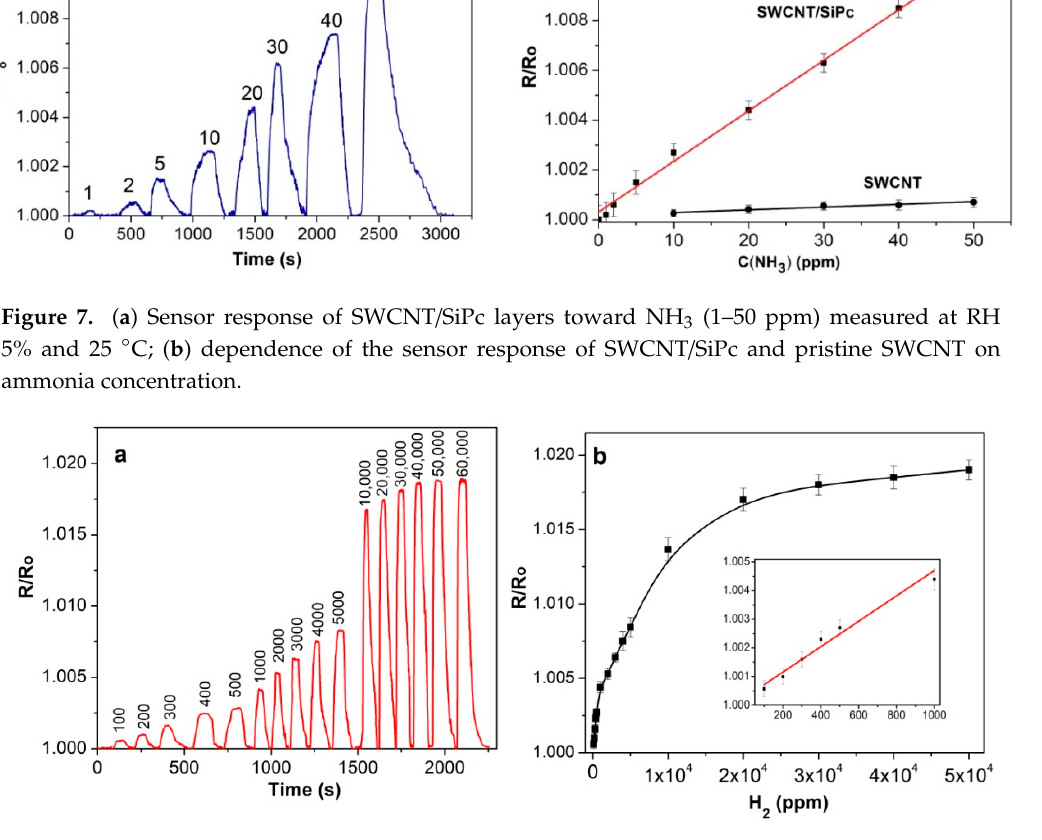
Figure 8. ( a ) Sensor response of SWCNT/SiPc layers toward H 2 (100–60,000 ppm) measured at RH 5% and 25 °C; ( b ) Dependence of the sensor response on hydrogen concentration.